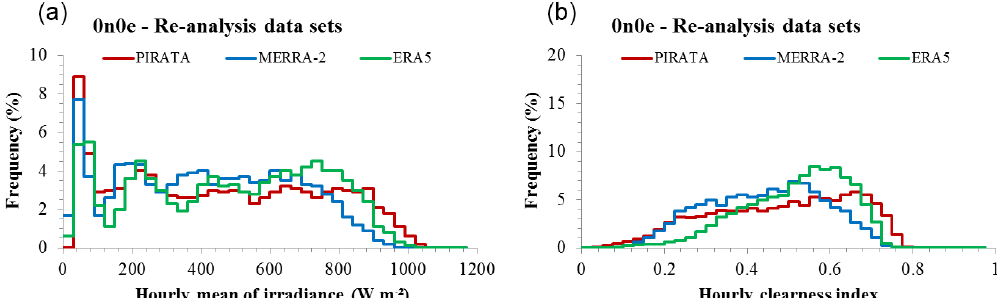
Figure A5. Frequency distributions of PIRATA measurements (red) and data sets (MERRA-2: blue, ERA5: green) at 0 ◦ N, 0 ◦ E for E (a) and KT (b) . If the coloured line is above (below) the red one for a given sub-range of values, it means that the data set produces these values too frequently (too rarely) with respect to the PIRATA